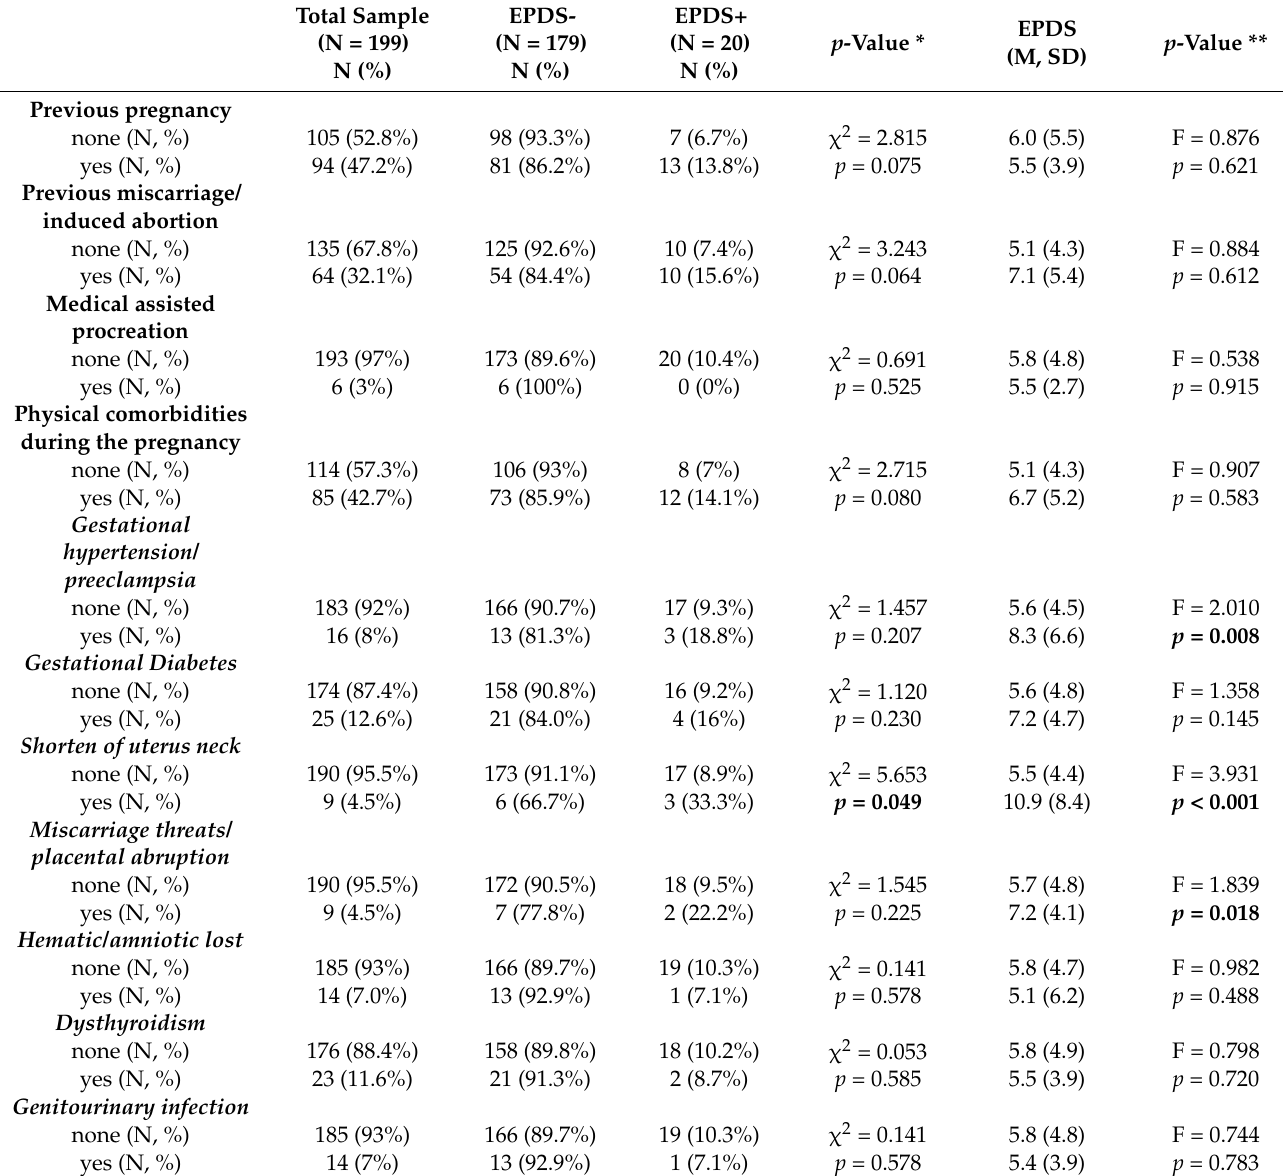
Table 3. Gynecological-obstetric characteristics of the